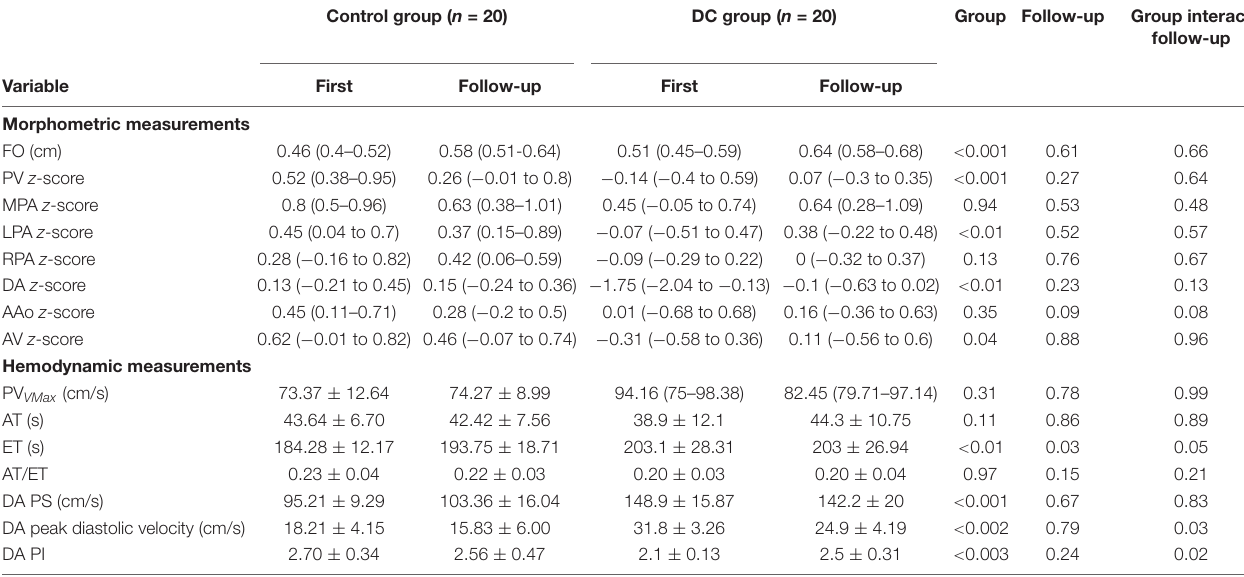
TABLE 7 | Series examinations of DA constriction fetuses with two-dimensional echocardiography and Doppler measurements. Control group ( n = 20) DC group ( n = 20) Group Follow-up Group interact